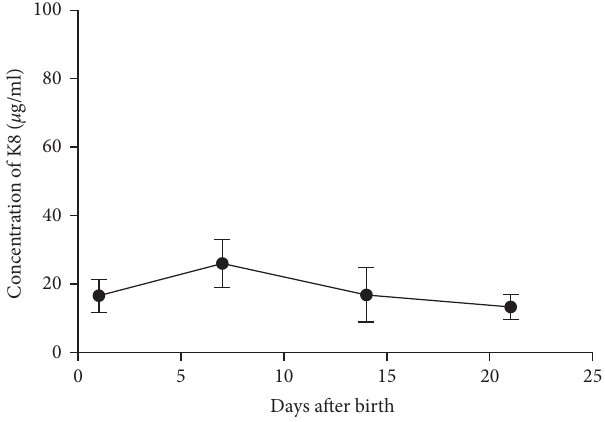
F IGURE 4: Serial fecal K8 of non-NEC neonates. To vertify the sta- bility of K8 in non-NEC neonates after birth, we tested fecal K8 of non-NEC neonates once a week for 4 weeks. Fecal K8 levels in non- NEC preterm neonates were detected using the described modi fi ed ELISA protocol at different time points after birth (mean Æ SEM) ( n =5). The results showed that serial fecal K8 of non-NEC neo- nates is stable at a low level for several weeks after birth.